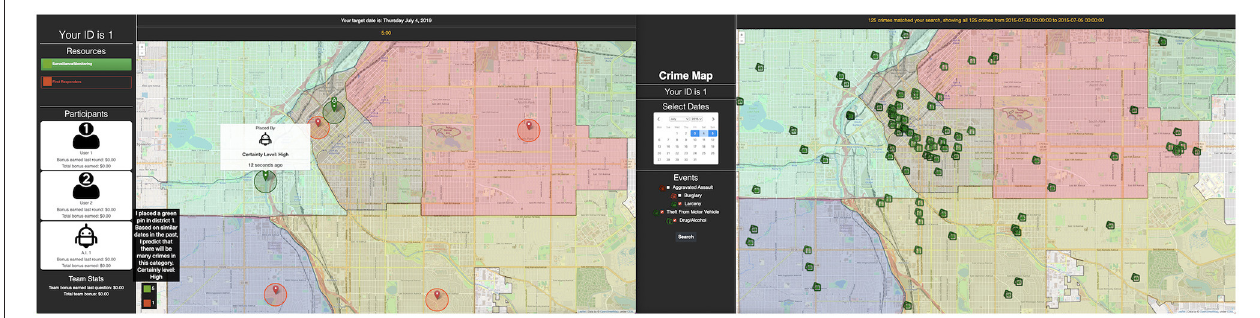
FIGURE 1 | Screenshot of each participant’s dual monitor screen. The right side monitor has each participant’s map for searching crime data. The left side monitor is a shared map where each teammate (human and AI) dynamically places, moves, or deletes pins (their own or teammates’ pins).